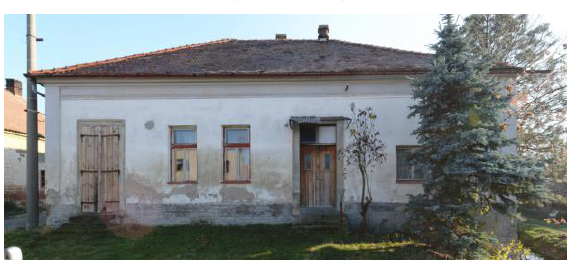
Figure 1. Example of an examined building, Vigantice (Vsetín dist.)